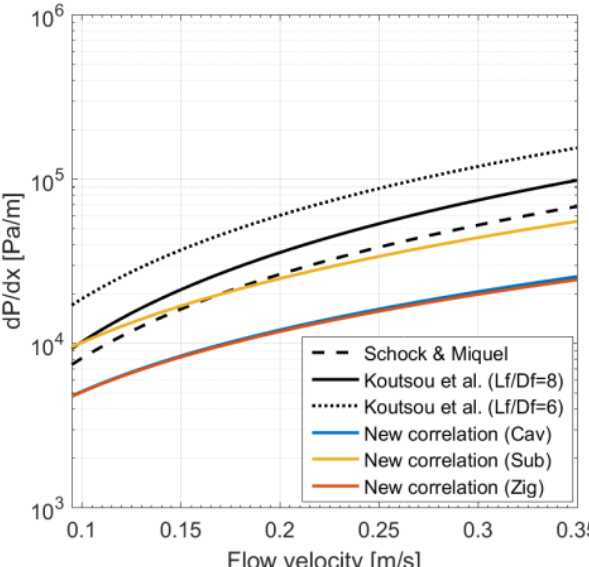
Figure 7. Comparison of pressure gradient calculated by different correlations: Schock and Miquel [30] and Koutsout et al. [26] expressed in Equations (23) and (24), respectively, and our new correlations for three spacer configurations.